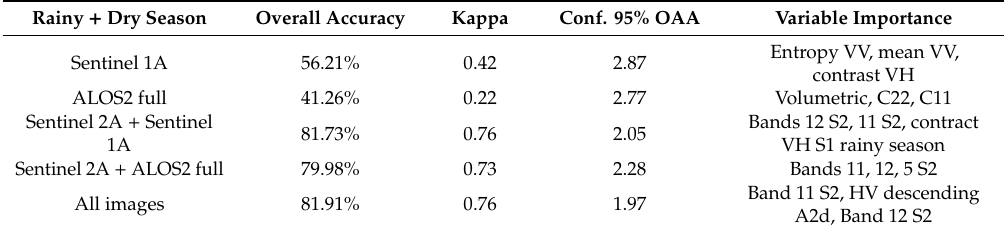
Figure 8. Producer’s ( A ) and user’s ( B ) accuracy of classifications based on single-sensor and optical / SAR-combinations for the four Cerrado types. Only data acquisitions during the dry season were considered. Table 4. Overall accuracy, kappa values, confidence interval 95% OAA, the three most important variables for the classifications according to Random Forest variable importance for Sentinel 2A (S2), ALOS PALSAR 2 full (A2f), ALOS PALSAR 2 dual (A2d), TanDEM X (TX), and Sentinel 1A (S1). The parameters listed in the variable importance are the PC1 derived from the PCA, except for the images from TanDEM-X, as only one acquisition was available. All data acquisitions during the dry and rainy season were